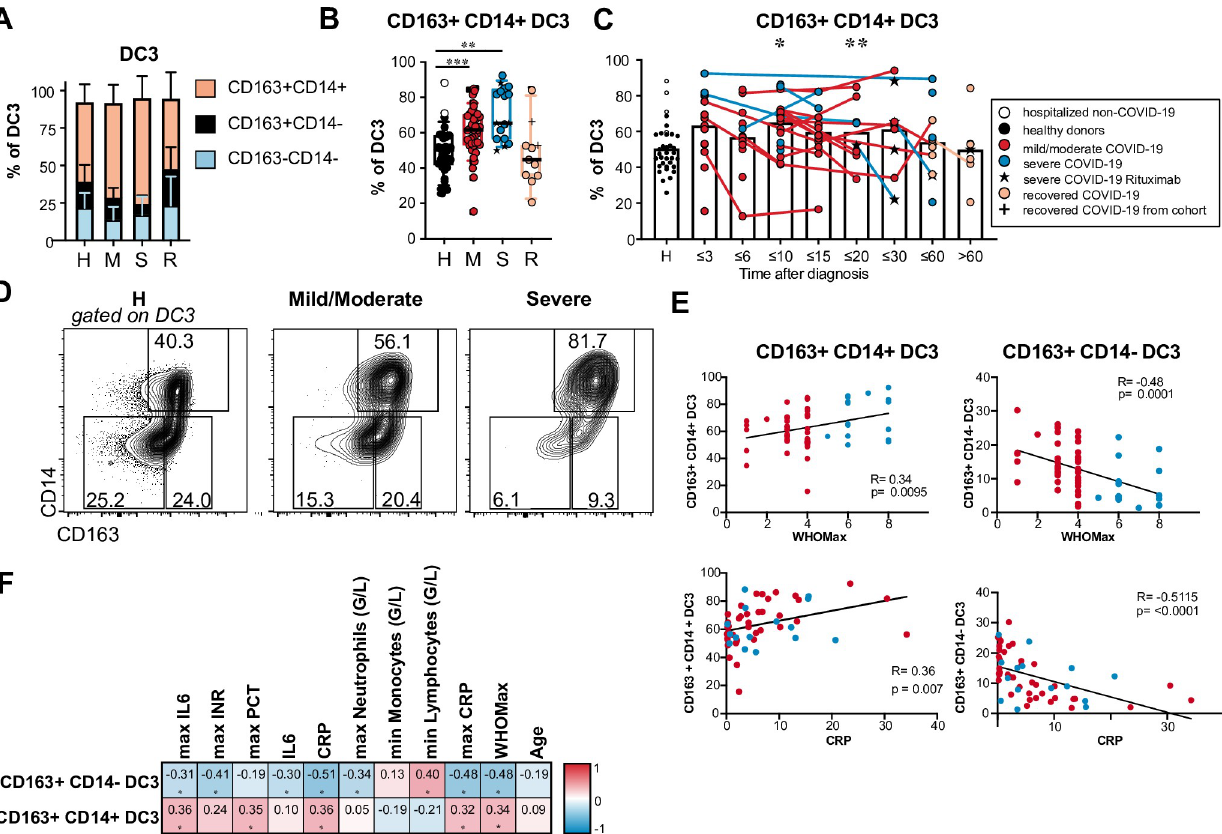
Fig 3. Increased percentage of CD163 + CD14 + cells in DC3 of COVID-19 patients. (A, B) Frequencies of DC3 subtypes identified by CD163 and CD14 expression are shown for healthy/non-COVID donors (H, n = 31), patients with mild/moderate (M, n = 39) and severe disease (S, n = 18) at the first analysis timepoint and recovered patients (R, n = 11). (B) Results for individual patients are indicated by symbols as in Fig 2 (Kruskal-Wallis test with Dunn’s correction, n = 99). (C) Frequency of CD163 + CD14 + cells within DC3 in all patients of the cohort at different grouped time points after diagnosis. Connected lines represent multiple measurements of the same donor at different time points. Columns indicate the mean (Kruskal-Wallis test with Dunn’s correction, n = 124). � p < 0.05, �� p > 0.01, ��� p < 0.001. (D) CD14 and CD164 expression in DC3. Representative results of one healthy donor and two patients with moderate and severe COVID-19 are shown. (E) Correlation of relative frequencies of CD163 + CD14 + and CD163 + CD14 – cells within DC3 with WHO max score (n = 57) and CRP concentration in the plasma (n = 55) at the same time point. Spearman’s rank correlation coefficients, p-values and linear regression lines are shown. (F) Correlation with inflammatory markers, blood cell counts, disease severity and age. Spearman correlation coefficients (-1 to 1) and adjusted p-values are shown.